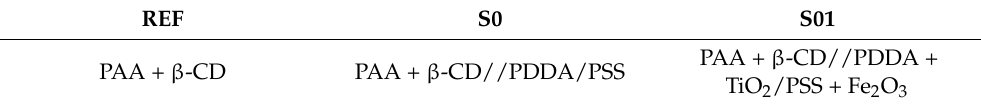
Table 1. Summary table of the analysed functional coatings before dyes